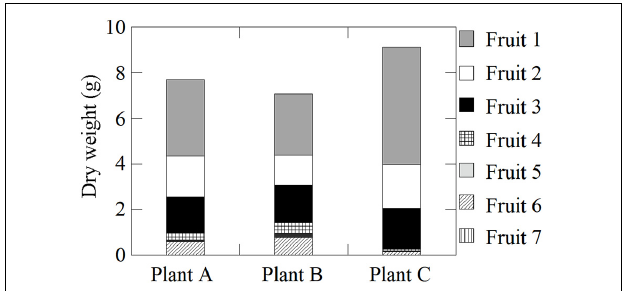
FIGURE 1 | Dry weights of fruits on the same inflorescences of Plants